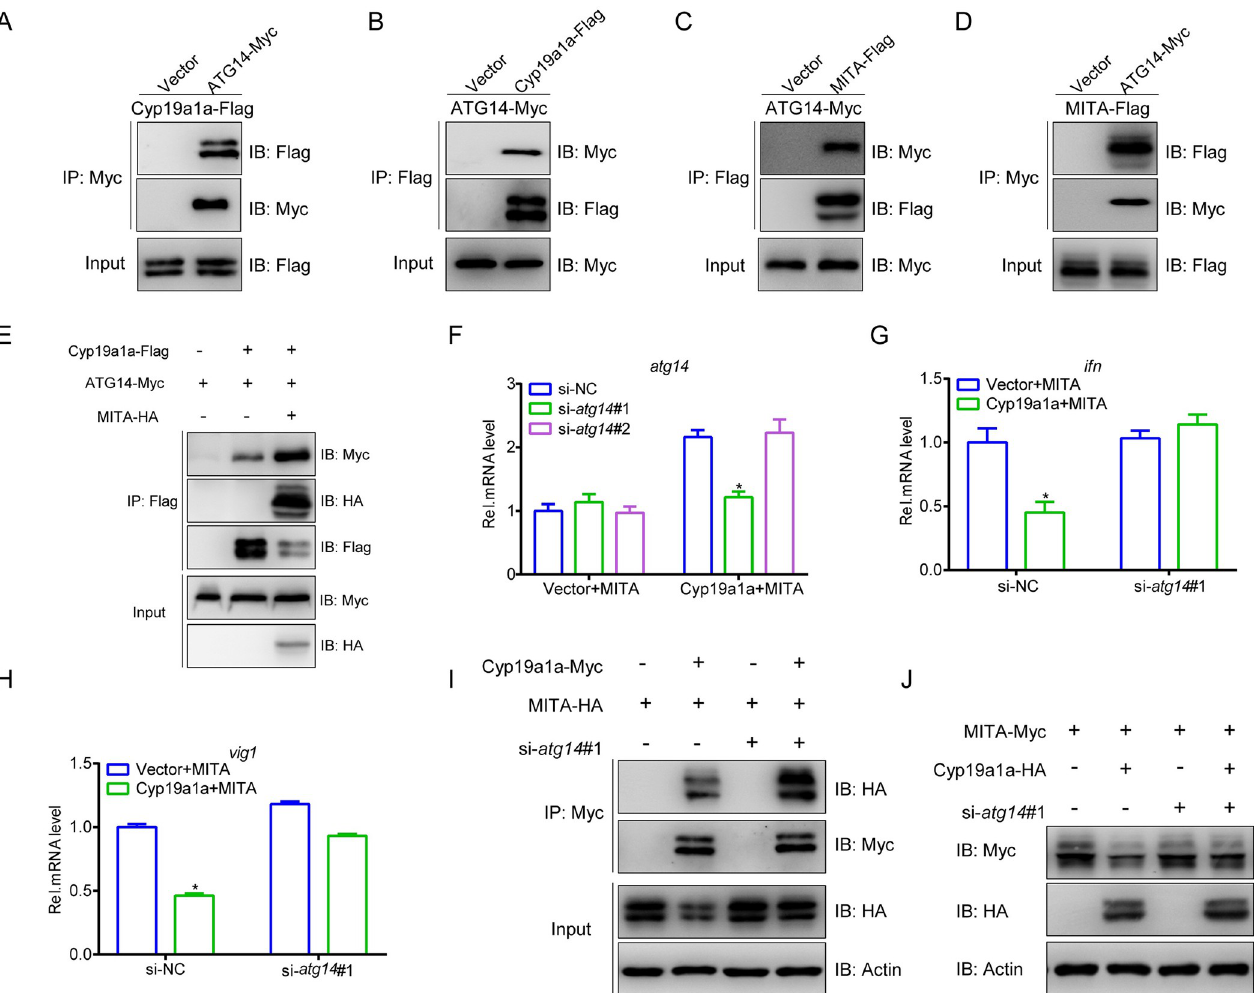
Fig 7. ATG14 is essential for Cyp19a1a mediated MITA autophagic degradation. (A-D) EPC cells were transfected with the indicated plasmids (5 μ g each). After 24 h, cell lysates were IP with anti-Myc or anti-Flag affinity gel. Then the immunoprecipitates and WCLs were analyzed by IB with the anti-Myc and anti- Flag Abs, respectively. (E) EPC cells were transfected with the indicated plasmids (4 μ g each). After 24 h, cell lysates were IP with anti-Flag affinity gel. Then the immunoprecipitates and WCLs were analyzed by IB with the anti-Myc, anti-HA, and anti-Flag Abs, respectively. (F) EPC cells were transfected with 100 nM si- atg14 #1, si- atg14 #2, or si-NC (negative control). At 6 h post-transfection, the cells were transfected with 1.5 μ g MITA-Myc plus 1.5 μ g Cyp19a1a-Flag or empty vector. At 24 h post-transfection, total RNAs were extracted to examine the transcriptional levels of ATG14. (G and H) EPC cells were transfected with 100 nM si-NC or si- atg14 #1. At 24 h post-transfection, cells were co-transfected with 1.5 μ g MITA-Myc and 1.5 μ g Cyp19a1a-Flag or empty vector for 24 h before qPCR analysis was performed. The relative transcriptional levels were normalized to the transcription of β -actin and represented as fold induction relative to the transcriptional level in control cells, which was set to 1. (I) EPC cells were transfected with 100 nM si-NC or si- atg14 #1. After 24 h, the cells were transfected by the indicated plasmids (5 μ g each) for 24 h. Cell lysates were IP with anti-Myc affinity gel. Then the immunoprecipitates and WCLs were analyzed by IB with the indicated Abs. (J) EPC cells were transfected with 100 nM si-NC or si- atg14 #1. At 24 h post-transfection, cells were co-transfected with 1.5 μ g MITA-Myc plus 1.5 μ g Cyp19a1a-HA or empty vector for 24 h. The cell lysates were subjected to IB with anti-Myc, anti-HA, and anti- β -actin